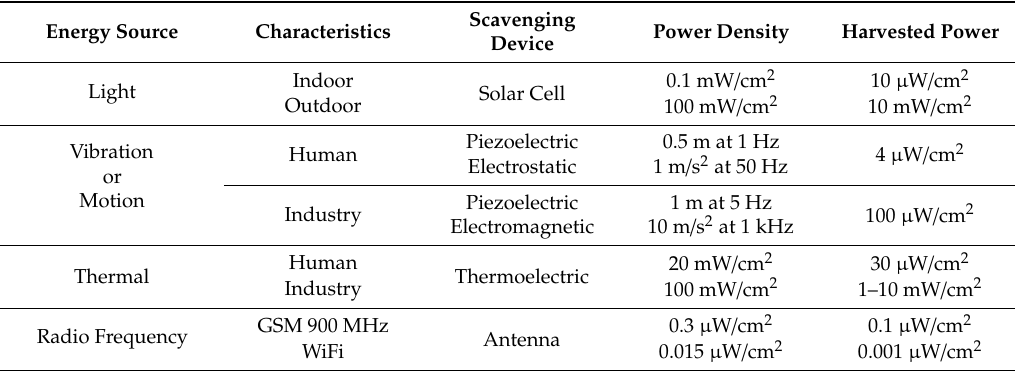
Table 2. Harvested power range from ambient sources [89].